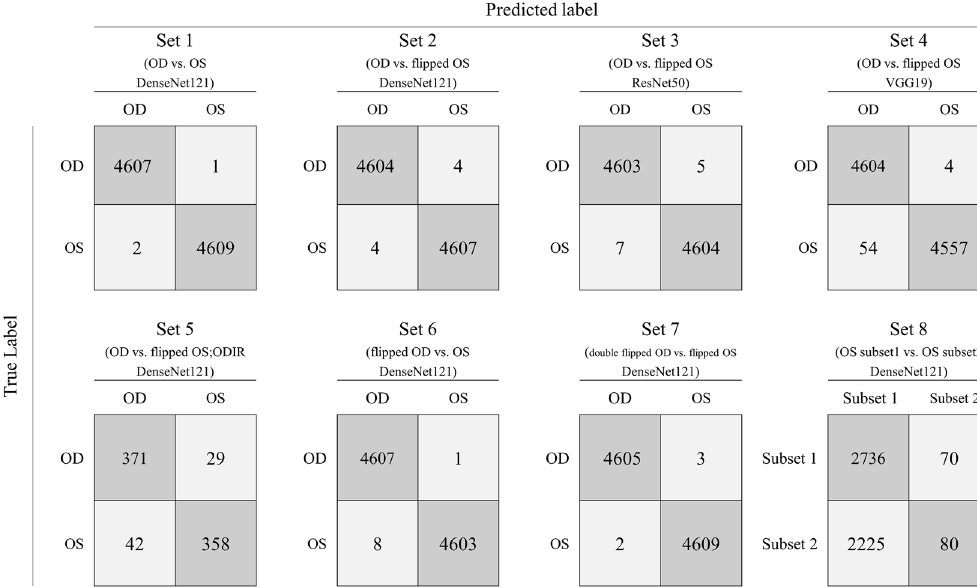
Figure 2. Confusion matrix for the test sets. Test Set accuracies were higher than 99% in all Sets but 5 and 8. The depth and structure of the CNN affected the accuracy slightly (Sets 2, 3, and 4; DenseNet121: 99.91%, ResNet50: 99.86%, and VGG19: 99.37%). The ODIR dataset with DenseNet121 model showed a significantly lower accuracy (91.1%, area under the curve = 0.912, p < 0.001). For Set 8, 97.1% of the images were classified as subset 1, and the test set accuracy was 55.1% (area under the curve = 0.505, p = 0.548).